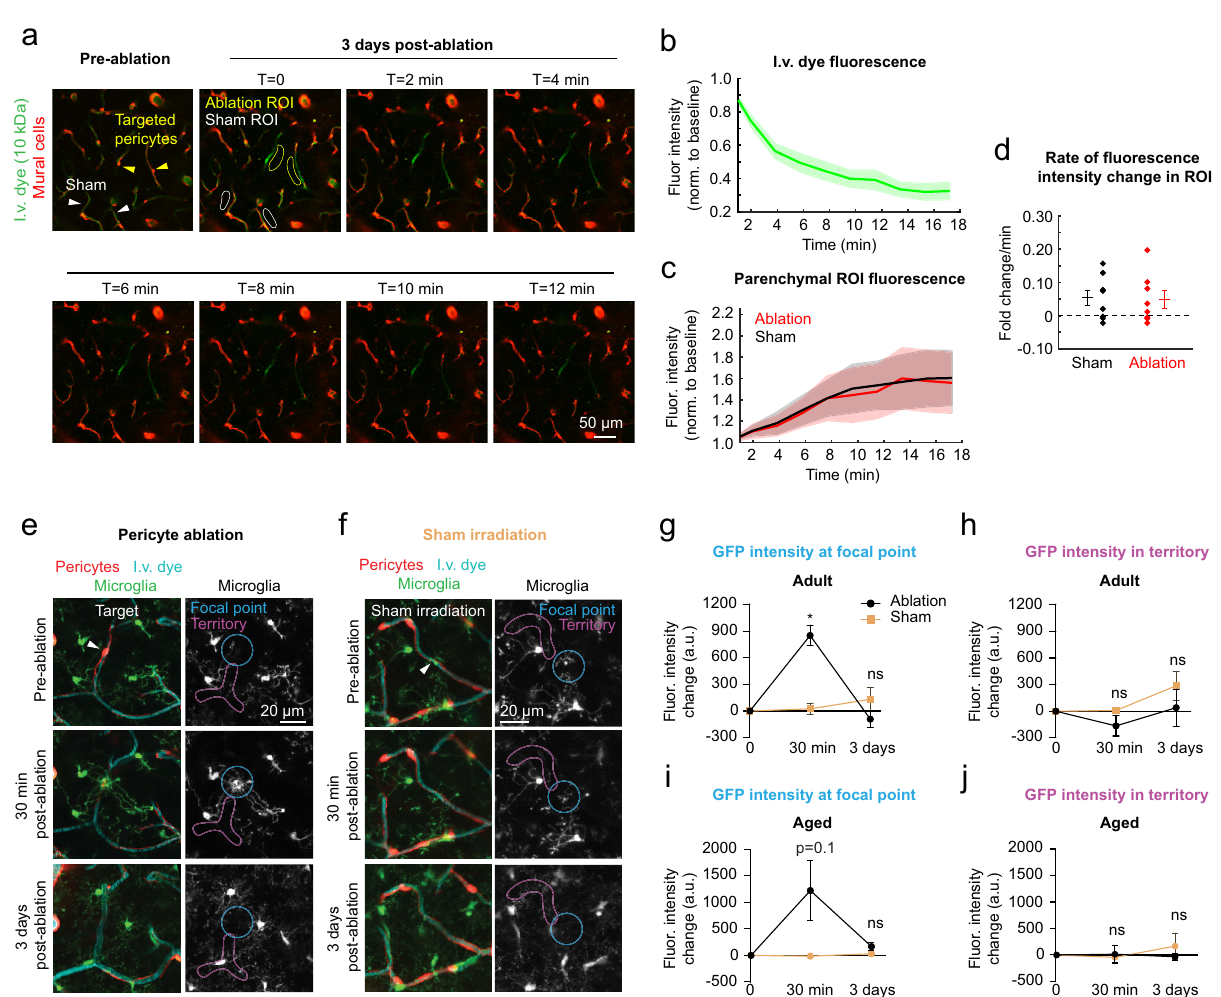
irradiationafter30minand3days.ROIsaredrawnintheregiondirectlyexposedto laser ablation or irradiation (focal point), or the capillary segments covered by pericyte processes (territory). This is a representative example from 3 ablation experiments in adult mice. GFP intensity in focal point ( g ) and territory ( h ) after pericyte ablation and sham in adult mice, shown in arbitrary units (a.u.). Two-way repeated measures ANOVA with Sidak ’ s multiple comparisons (two-sided). Focal point: F (1.45, 7.252)=24.41, overall effect *** p =0.0009. Pericyte ablation vs. sham irradiation * p =0.0216 at 30min; p =0.5504 at 3 days. Territory: F (1.149, 5.744)=3.170, p =0.1263. GFP intensity in focal point ( i ) and territory ( j ) in aged mice. Two-way repeated measures ANOVA. Focal point: F (1.03, 7.183)=3.214, overall effect p =0.1146. Territory: F (1.761, 12.33)=0.2922, p =0.7248. For g and h , n =3pericyteablations,4shamirradiationsfrom5micebetween3and6months ofage.For i and j , n =5pericyteablations,4shamirradiationsfrom3micebetween 18 and 24 months of age. Data presented as